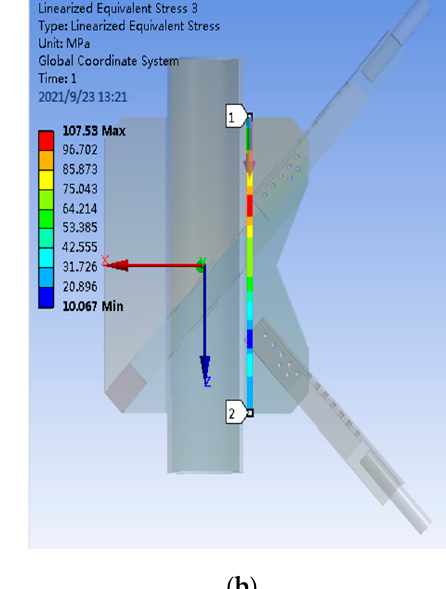
Figure 15. ( a ) Finite element model of PDLDPJ; ( b ) loading diagram of PDLDPJ; ( c ) meshing diagram of PDLDPJ.